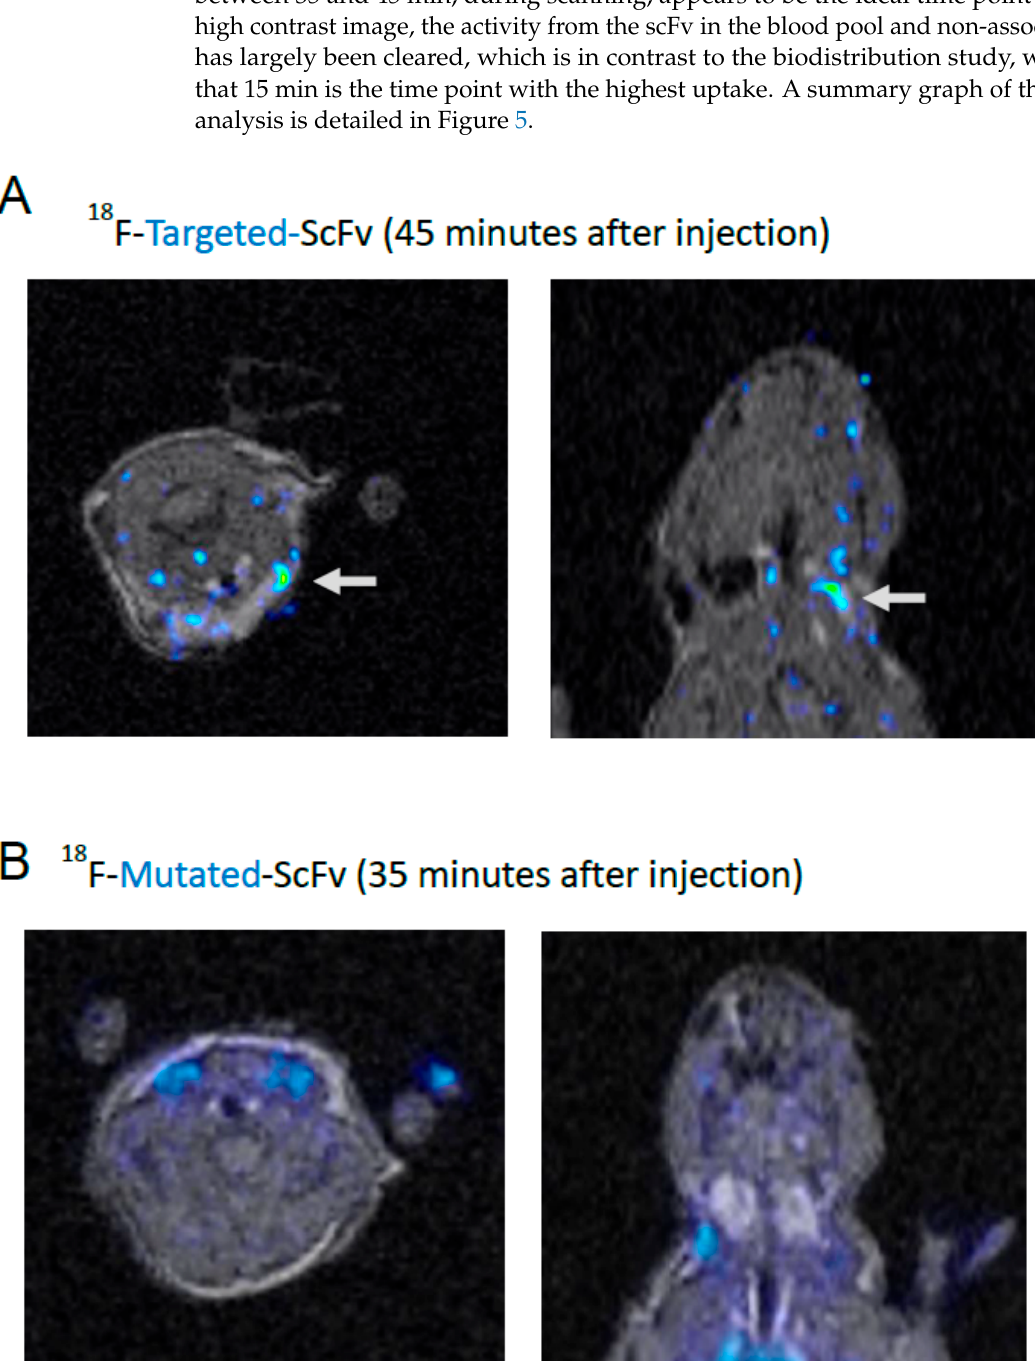
Figure 4. Co-registered PET/MRI scans of a mouse injected with 18 F-scFv-cys ( A ) shows co-registered PET/MRI scans of a mouse injected with [ 18 F]FBEM-radiolabelled targeted-ScFv. Both views show uptake in the target area (white arrow) where the FeCl 3 injury was performed in transverse and coronal views. ( B ) shows a co-registered PET/MRI image of a mouse injected with [ 18 F]FBEM-radiolabelled mutated-ScFv, and there is minimal radioactivity uptake in the target area. Representative results are shown.